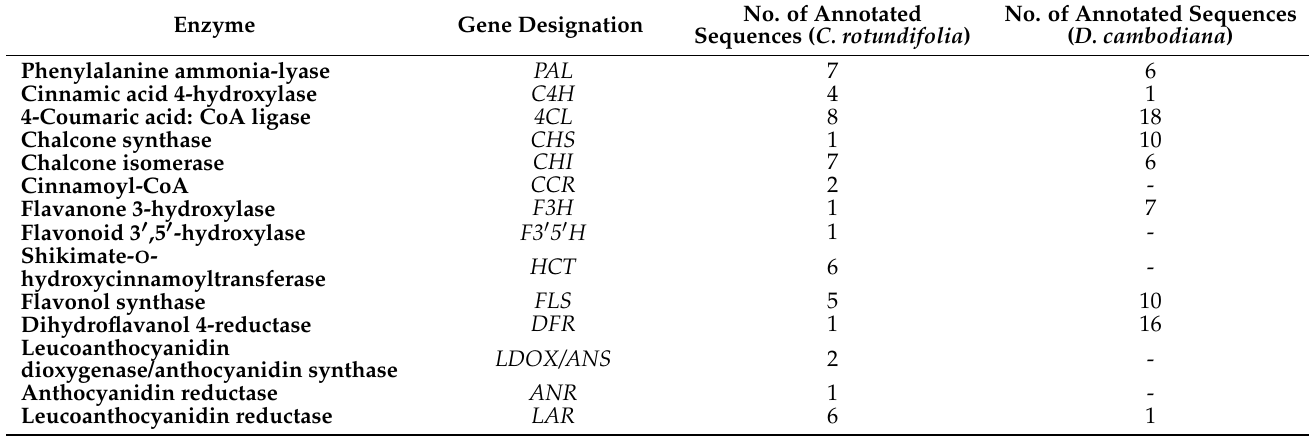
Table 2. Summary of annotated central genes involved in flavonoids biosynthesis in C. rotundifolia and D. cambodiana as previously reported